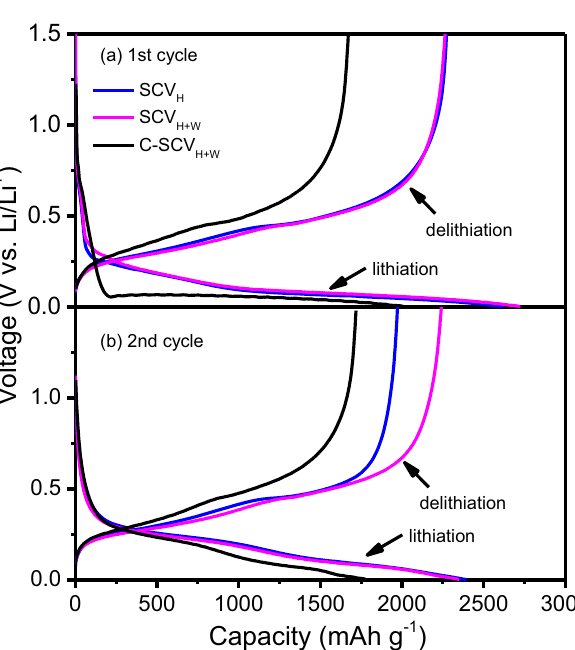
Figure 7. Voltage profiles of SCV H , SCV H + W and C-SCV H + W for ( a ) 1 st cycle and ( b ) 2 nd cycle conducted at current density 200 mA g − 1 between 0.002 V to 1.5